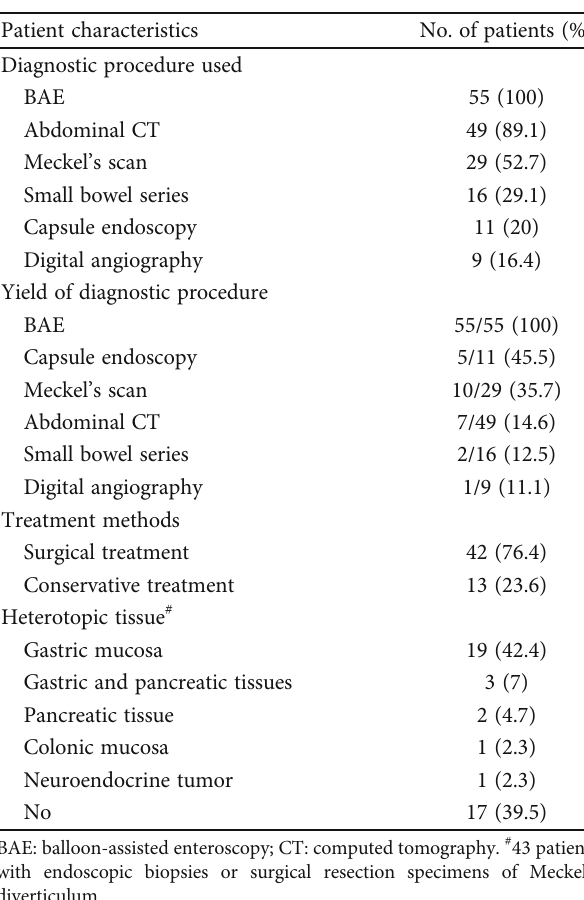
Table 3: Diagnostic yield of di ff erent modalities, treatment methods, histopathological fi ndings, and clinical outcomes of patients with Meckel ’ s diverticulum diagnosed by BAE ( n = 55 ).